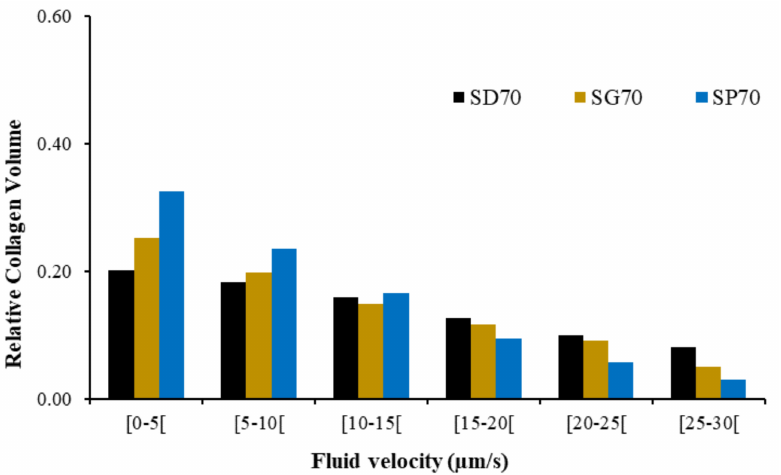
Figure 6. Fluid flow velocity distribution ( µ m / s) in the collagen substrate elements versus their relative volume, at peak compression, for the three FE